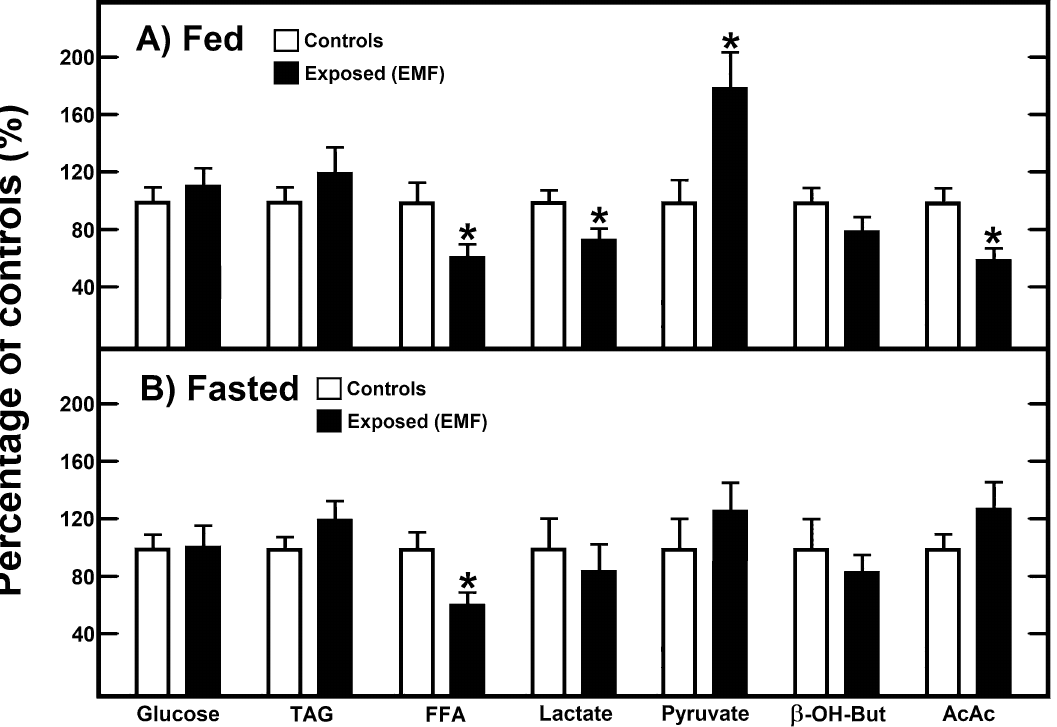
Figure 1. Effects of the single exposure to EMFs on glucose, lipids, and redox pair-metabolites in fed and fasted rats. Results are the mean ± SE of three individual observations per experimental group (6 control animals, and 6 treated rats). Blood samples were immediately taken after 15 min exposure to EMFs. Experimental groups are designated by symbols at the upper part of each panel. In panel A, control values (100%) for fed animals were glucose = 101 ± 9 mg·dL −1 , triacylglycerols (TAG) = 174 ± 15 mg·dL −1 , free fatty acids (FFA) = 3.8 ± 0.5 µmol·dL −1 , lactate = 1.26 ± 0.08 mmol·L −1 , pyruvate = 0.06 ± 0.01 mmol·L −1 , β-hydroxybutyrate (β-OH-but) = 0.16 ± 0.02 mmol·L −1 , and acetoacetate (AcAc) = 0.32 ± 0.06 mmol·L −1 . In panel B control values for fasted animals were: glucose = 77 ± 5 mg·dL −1 , TAG = 167 ± 14 mg·dL −1 , FFA = 5.2 ± 0.5 µmol·dL −1 , lactate = 1.89 ± 0.37 mmol·L −1 , pyruvate = 0.08 ± 0.02 mmol·L −1 , β-OH-but = 0.58 ± 0.12 mmol·L −1 , and AcAc = 0.18 ± 0.02 mmol·L −1 . Statistical significance: * p < 0.01 versus control